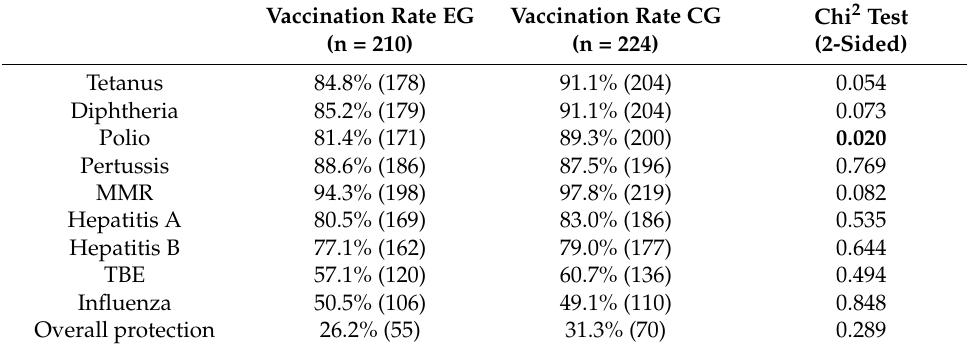
Table 1. Vaccination rates (absolute numbers) of the experimental (EG) and control groups (CG) at T0 and the results of the bivariate analysis by means of the chi-squared test. Overall protection is defined as a full vaccination status against all nine immunisations listed above. MMR = measles, mumps, rubella, TBE = tick-borne